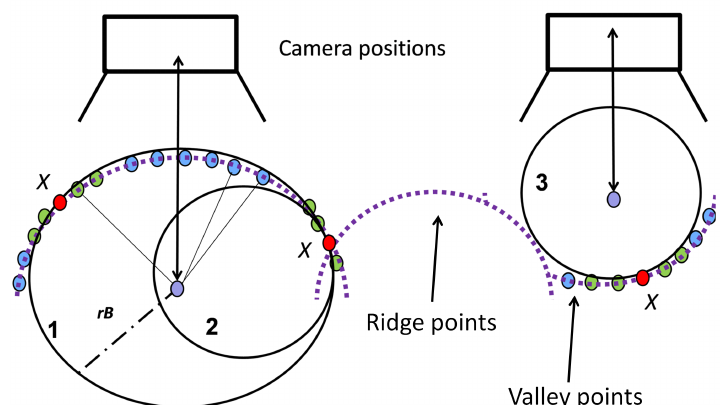
Figure 11. Scenario for berry quantification. Purple lines illustrate points of a grape bunch viewed in profile. Red circles depict the source point X , green circles the points used for the sphere approximation and blue circles the points within the sphere radius r B . Spheres 1–3 are spheres with a valid sphere radius and enough supporting points. They depict scenarios in three different evaluation